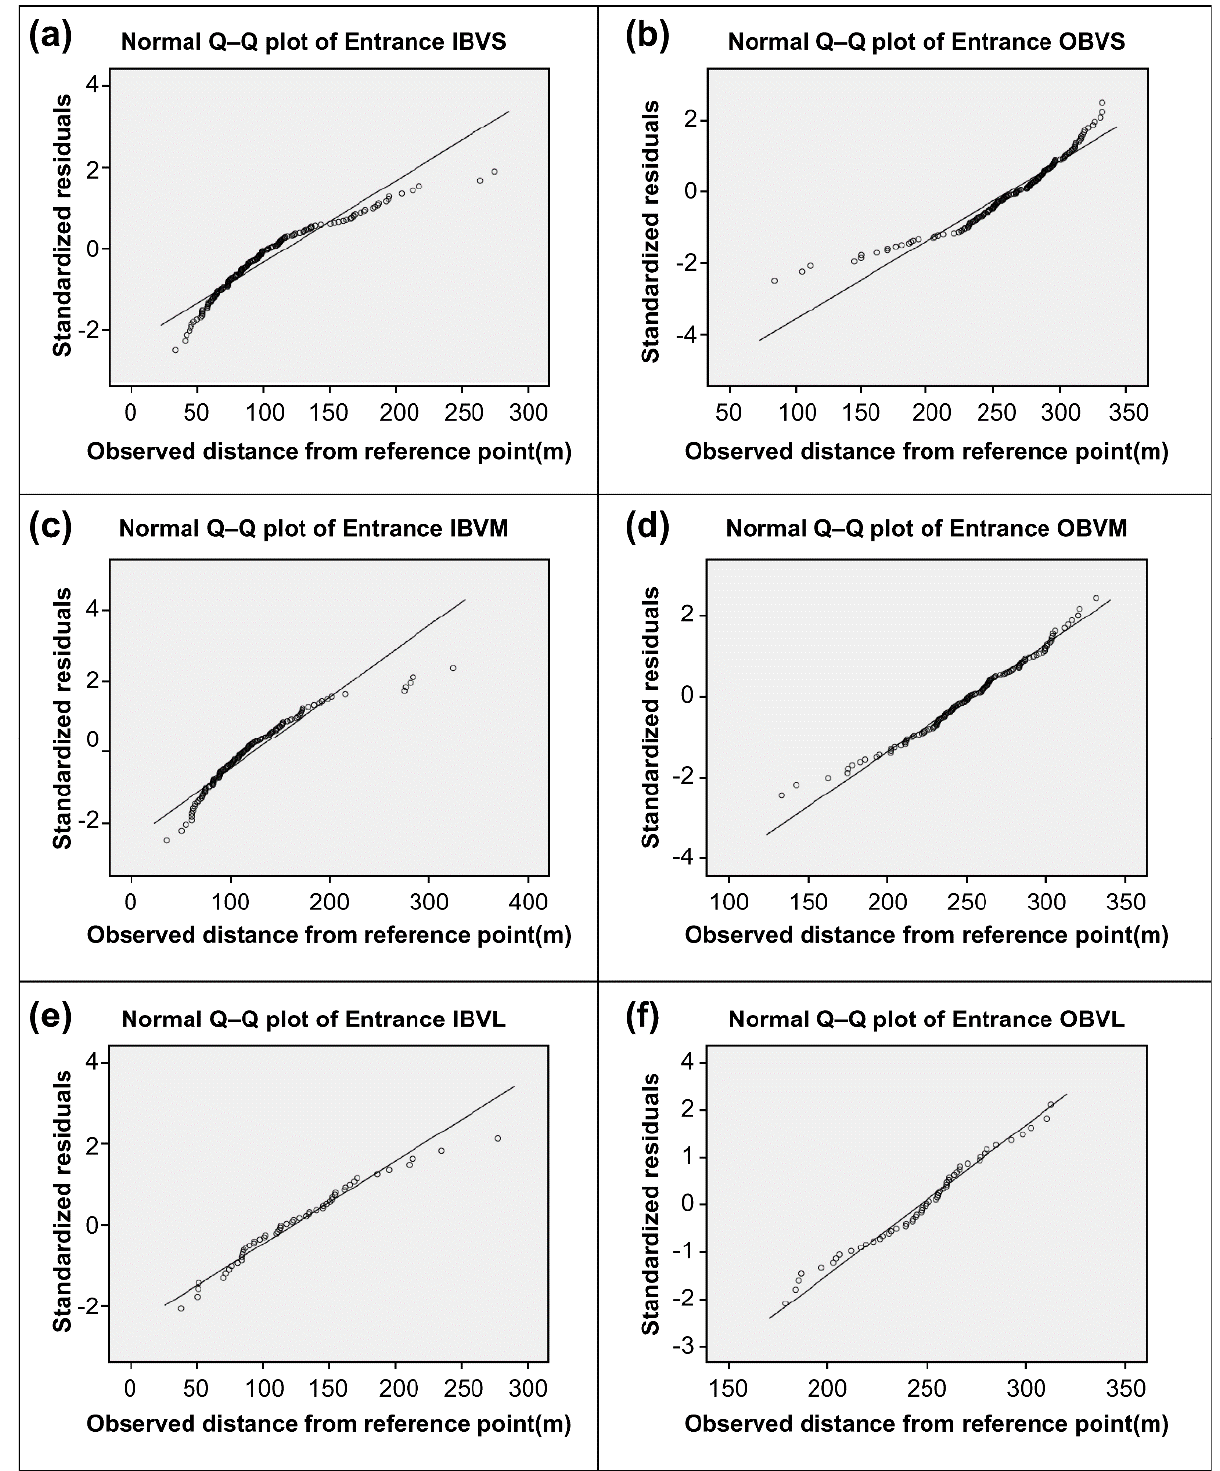
Figure A1. Normal Q–Q plot of the entrance part: ( a ) small IBVs, ( b ) small OBVs, ( c ) mid-sized IBVs, ( d ) mid-sized OBVs, ( e ) large IBVs, and ( f ) large OBVs .